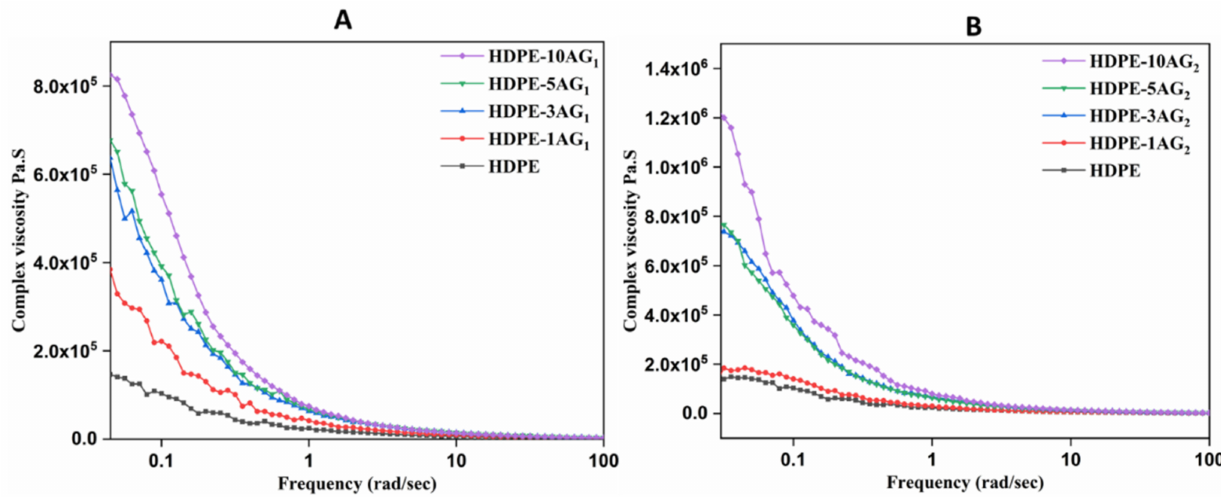
Figure 5. Complex viscosity data in HDPE/AG 1 ( A ) and HDPE/AG 2 ( B )